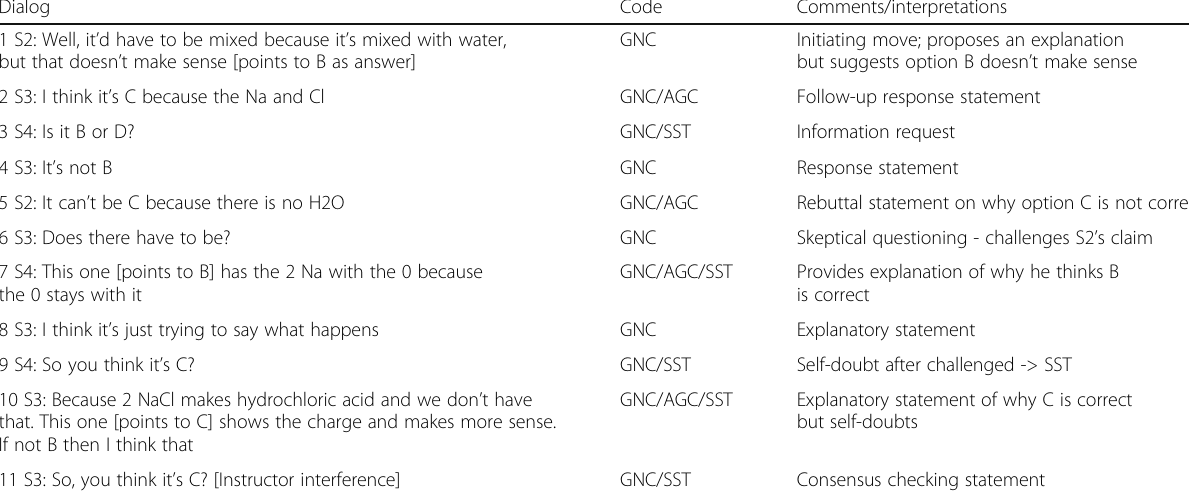
Table 3 Group 2D ’ s dialog on choosing correct equation for NaCl dissolved in water Dialog